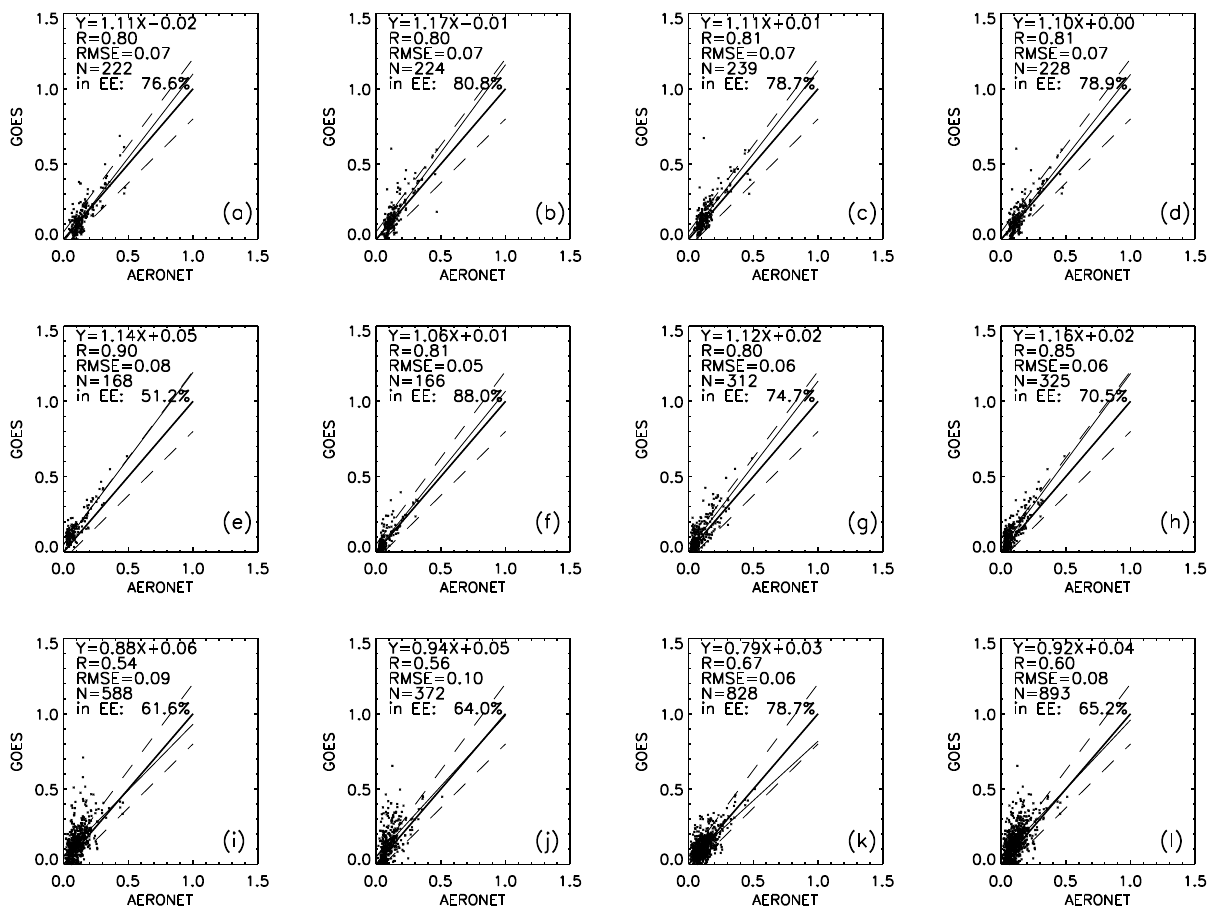
Fig. 7. Scatter plots of AOD for GOES-WEST vs. AERONET (column 1), GOES-EAST vs. AERONET (column 2), hybrid algo- rithm vs. AERONET (column 3), and combined algorithm vs. AERONET (column 4) at three AERONET sites: UCSB (top row), Rail- road Valley (middle row), and Boulder (bottom row). The regression lines are calculated through least-square fit. 1:1 lines (solid) and τ AERONET ± ( 0 . 05 + 0 . 15 τ AERONET ) lines (dashed) are also plotted in the figure. Statistics written in the plots include linear regression equations, correlation coefficients ( R ), root mean square error (RMSE), total number ( N ), and percentage within expected error (EE, ± ( 0 . 05 + 0 . 15 τ)